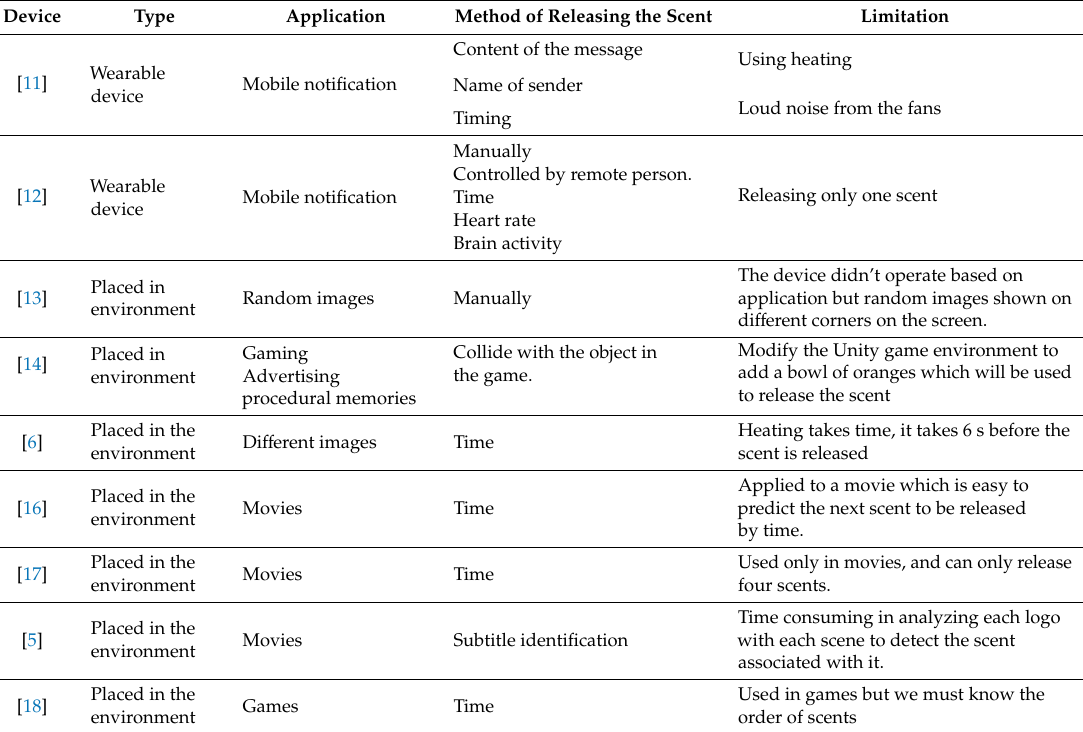
Table 1. Comparison between the olfactory displays.